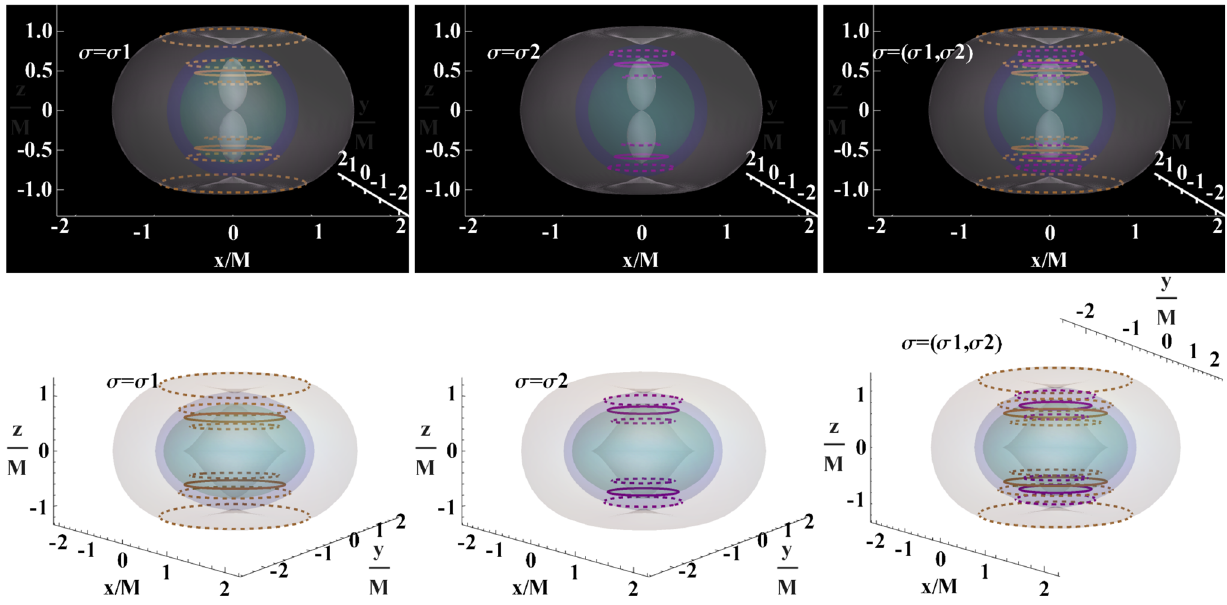
Fig. 18 Examples of horizons replicas are shown for fixed σ = 0 . 50466 and σ = 0 . 25, where σ ≡ sin 2 θ , in a BH geom- 1 2 etry with spin a (cid:9) γ ≡ 0 . 994298 M . The σ s parameters are selected according to the considerations in Fig. 17. Green sphere is the inner BH horizon r − , blue sphere is the outer BH horizon r + , light gray surfaces are the inner and outer ergosurfaces r ∓ (cid:9) . Brown orbits are replicas for σ = σ 1 , purple curves are replicas for σ = σ 2 . Dashed are replicas of the outer horizon, plain curves are replicas of the inner horizons. In upper line panels there are flat coordi- nates { x = r sin (θ) cos (φ), y = r sin (θ) sin (φ), z = r cos (θ) } (central singularity is the point r = 0 at x = 0, y = 0